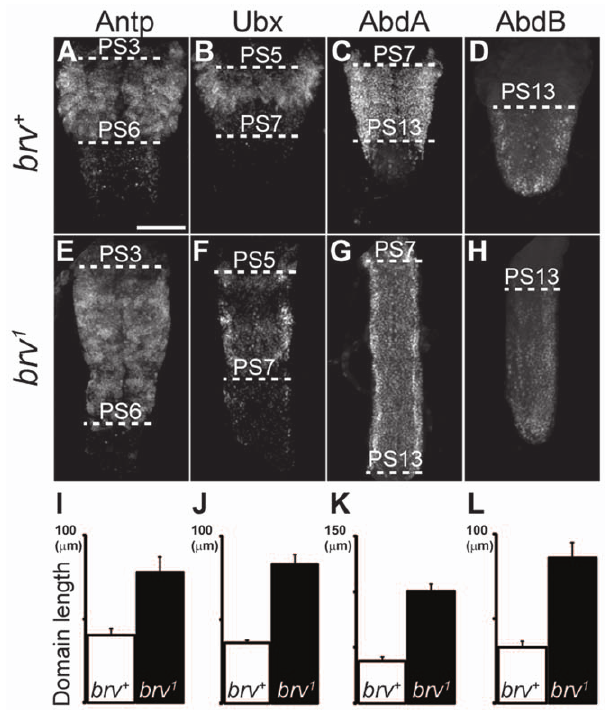
Figure 4. Parasegmental identity and sequence of homeotic gene expression domains are not altered in brv mutants. L3 larva brains from brv + (A–D) and brv 1 mutants (E–H) were immuno- stained with anti-Antp (A, E), anti-Ubx (B, F), anti-AbdA (C, G), and anti- AbdB (D, H). (I–L) Histograms comparing the average lengths of the homeotic expression domains (I: Antp; J: Ubx; K: AbdA; L: AbdB) are shown. Dashed lines indicate parasegmental (PS) boundaries. Bar: 20 m